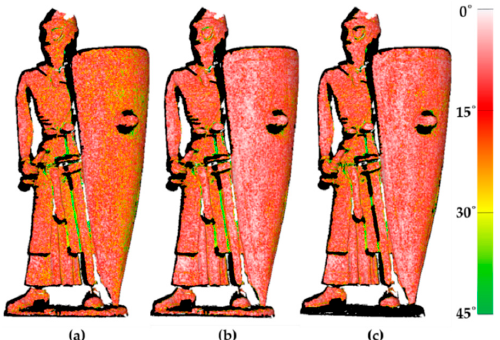
Figure 11. Angular deviation of the normal vector to the ground truth. ( a ) Normal vector obtained by stereo vision; ( b ) Normal vector after applying Nehab’s algorithm, which uses normal vector from the traditional photometric stereo method; ( c ) Normal vector after applying Nehab’s algorithm, which uses normal vector from the re-projection method.